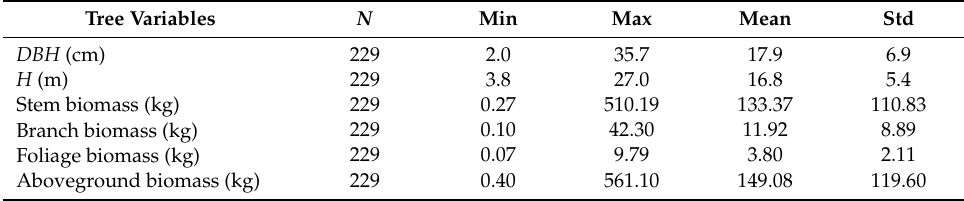
Figure 1. Geographical position of study area and sampling plots in Heilongjiang Province of Northeast China. Table 1. Descriptive statistics of tree variables for all data.